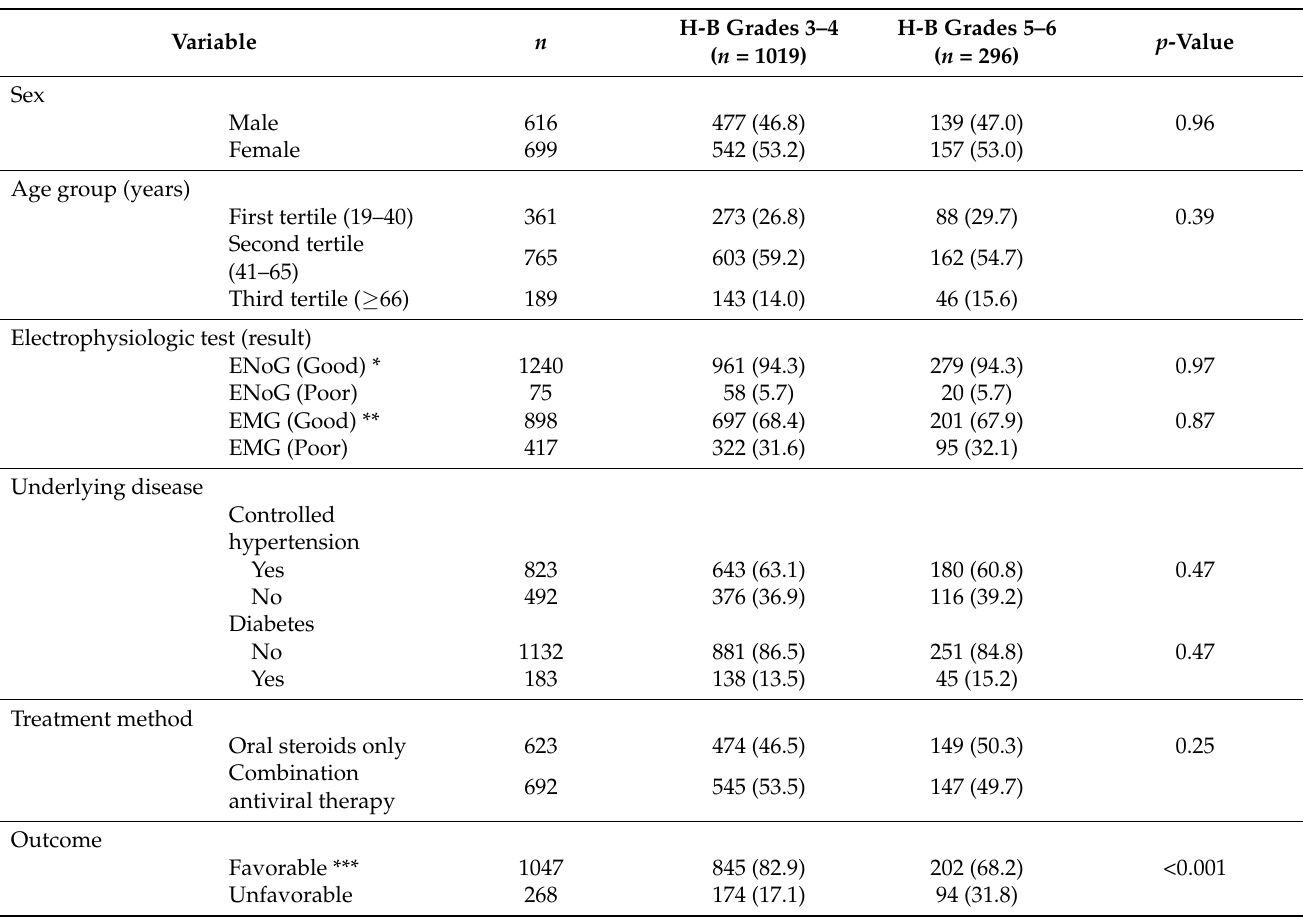
Table 1. Patients’ demographic and clinical characteristics stratified by initial H-B